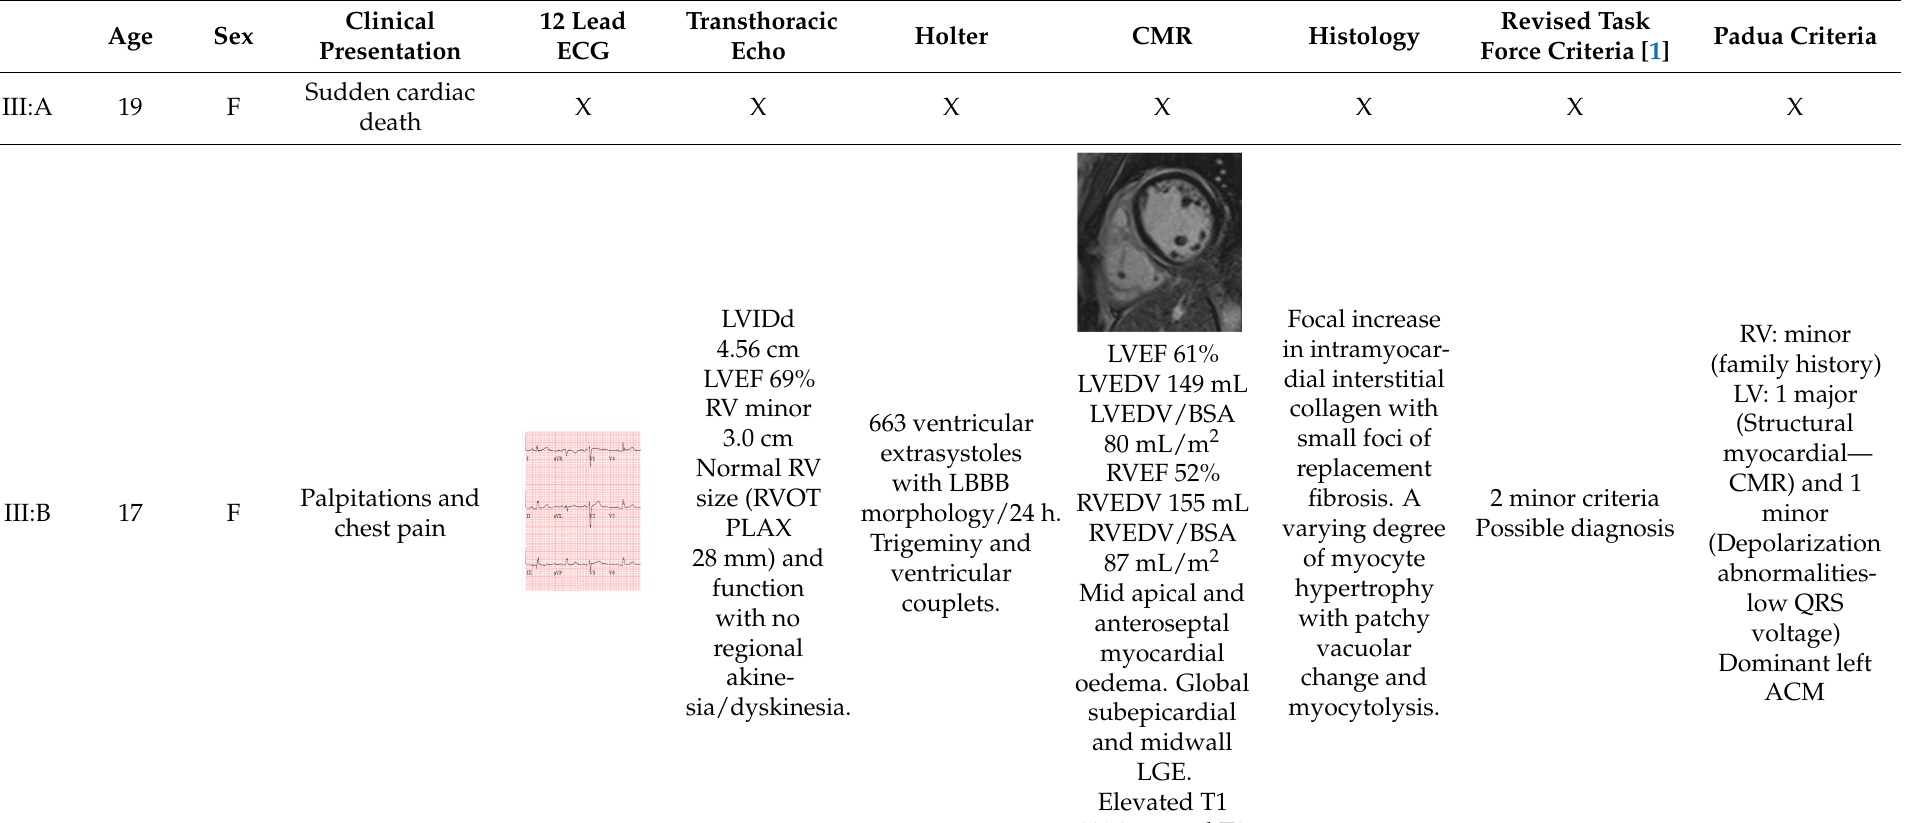
Table 1. Summary of investigations and the revised Task Force